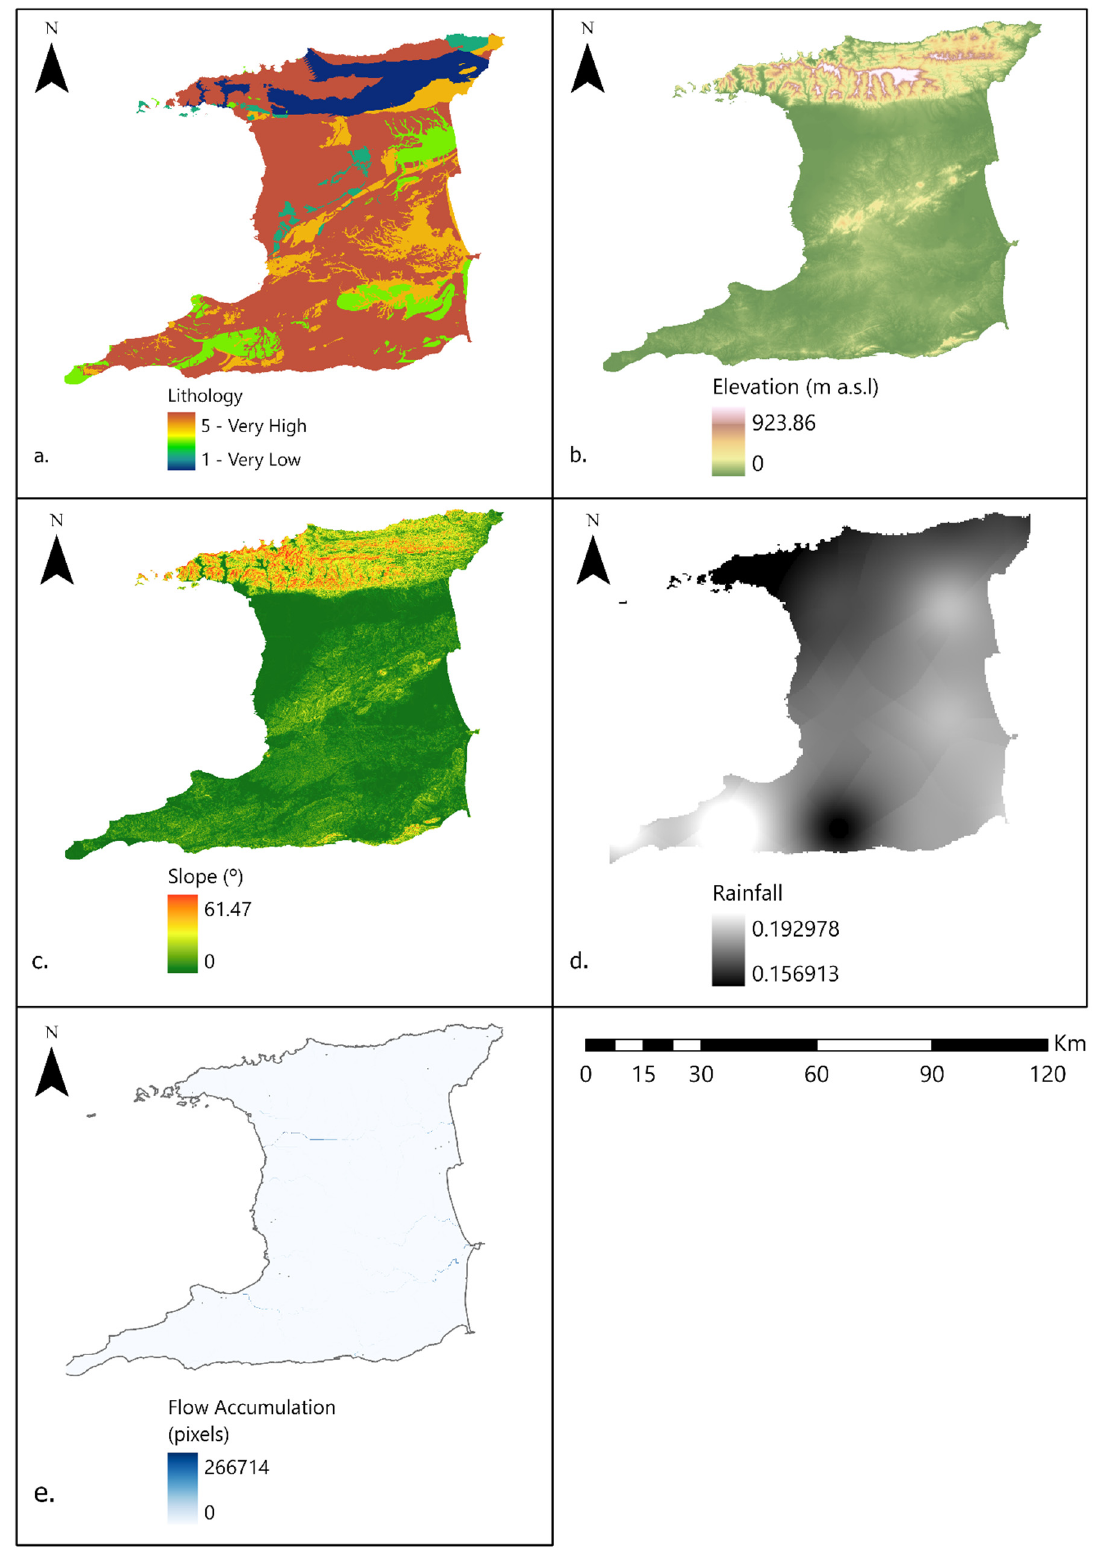
Figure 5. Conditioning factors used ( a – e ): ( a ) lithology; ( b ) elevation; ( c ) slope; ( d ) rainfall; ( e ) flow accumulation.